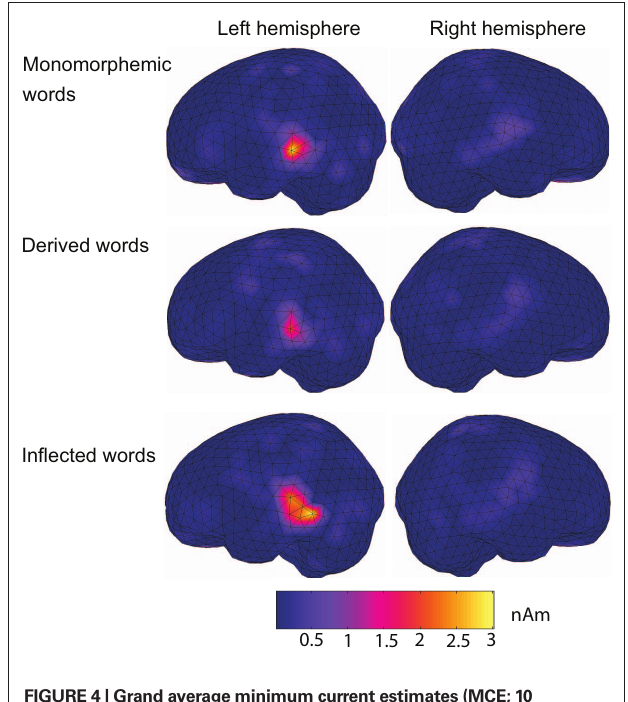
FiGuRE 4 | Grand average minimum current estimates (MCE; 10 participants) calculated for monomorphemic, derived, and inflected words in the 170–210 ms time-window after the critical